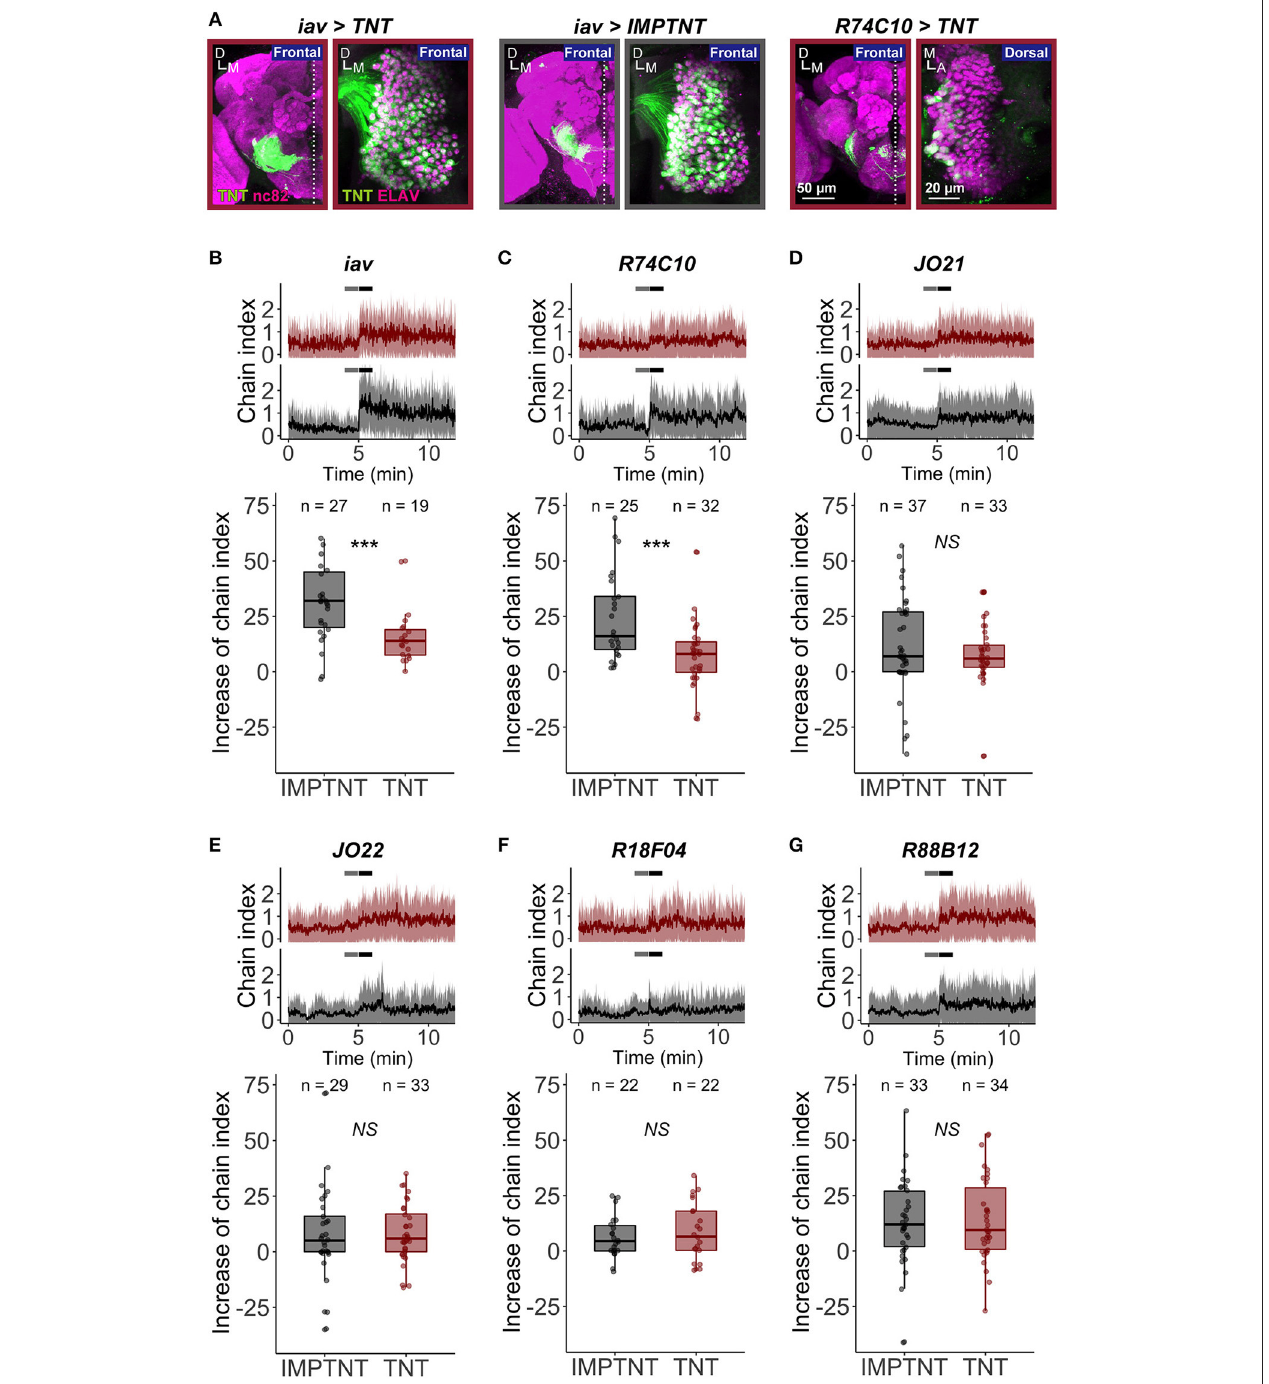
FIGURE 8 | The role of JO-A neurons in the sound-evoked behavior. (A) Tetanus toxin (TNT) expression pattern of iav > TNT , iav > IMPTNT , and R74C10 > TNT . TNT and IMPTNT expression was labeled with anti-TNT antibodies (green signals). Brain (Left) and Johnston’s organ in the antennal second segment (Right) are shown. Neuropils in brains and nuclei of JO neurons in antennae were labeled with nc82 antibodies and ant-ELAV antibodies, respectively (magenta signals). A, anterior; D, dorsal; M, medial. (B–G) The chain index in response to an artificial pulse song when iav (B) , R74C10 (C) , JO21 (D) , JO22 (E) , R18F04 (F) , and R88B12 neurons (G) are silenced, respectively. (Top) Red and gray traces show the time-course of the chain index of experimental (TNT, red) and control (IMPTNT, gray) flies, respectively. Sound playback starts at 5 min. Thick lines and shadows represent mean ± standard deviation. Time windows for two temporal phases (before and after) are indicated in gray and black horizontal lines. (Bottom) Increases from the temporal phase “before” to that of “after” are plotted. Each point indicates the increase in each experiment. Box plots show median (solid horizontal line), 50th percentile (box outline), and 90th percentile (whiskers) values.